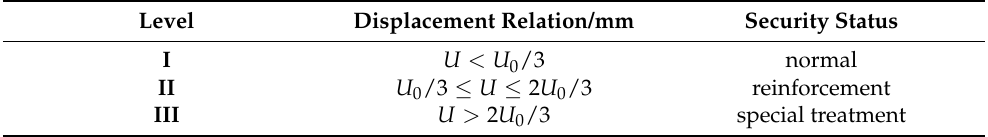
Table 1. Displacement Management Level.